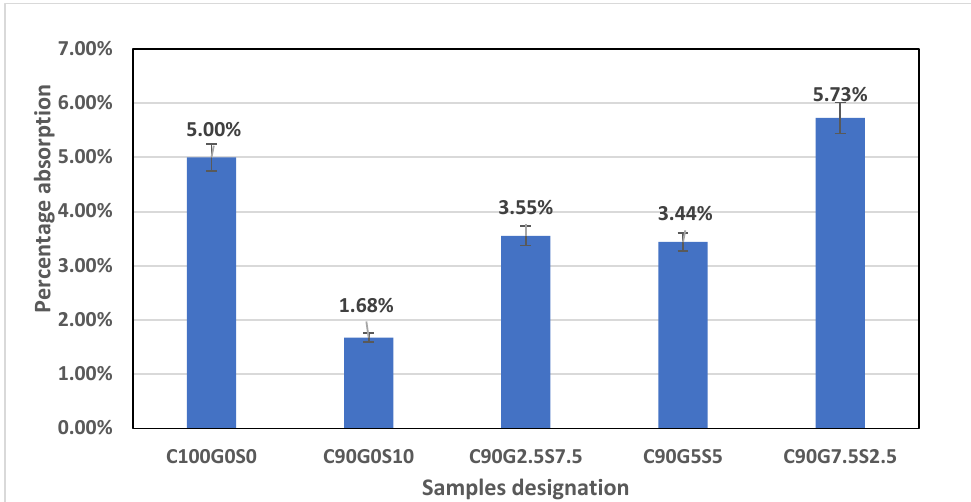
Figure 5. Water absorption in blended silica-fume/glass concrete.